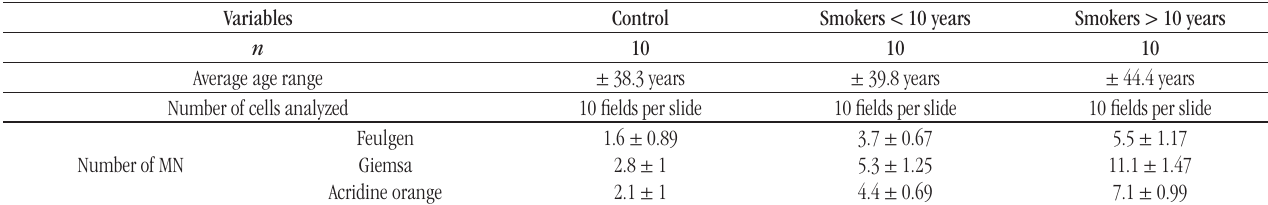
table 3 – Methodological characteristics and results of study number